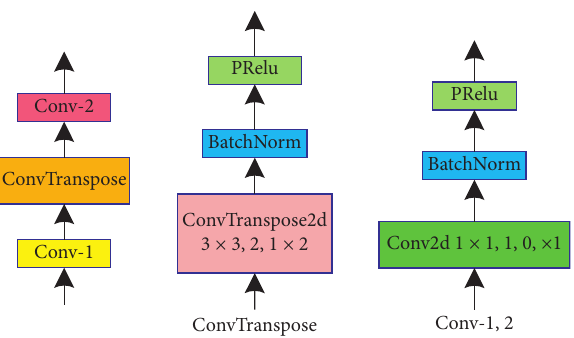
Figure 4: Decoder 5.